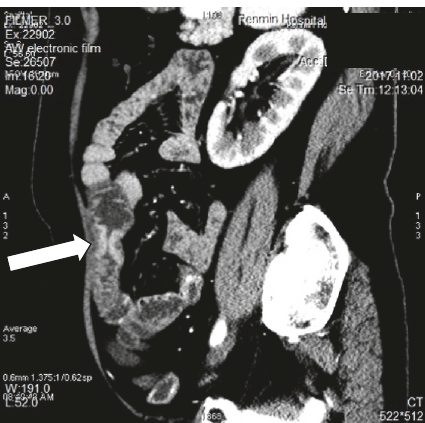
Figure3:CTscanshowingalinearcalcificationconsistentwithliver fibrosis due to S. japonicum .